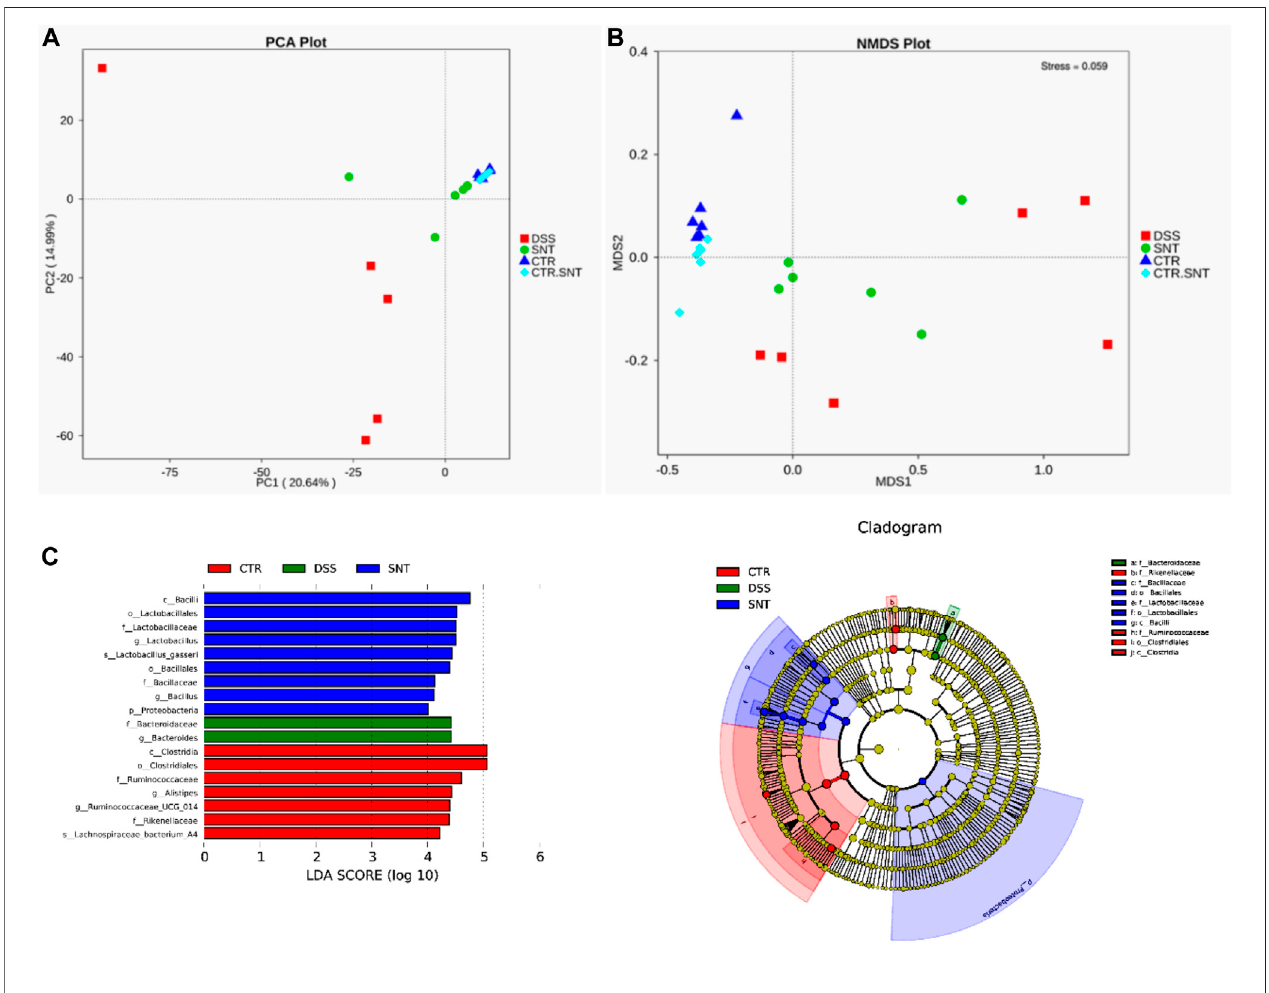
FIGURE7| Diversity analysisofgut microbiota inmice. (A) PCA analysis. (B) NMDS analysis. (C) LEfSe analysis. Bcteroidaese , Bacteroides in theCRC groupand Lactobacillales , Lactobacillaceae , Bacillales , Bacillaceae intheCRC +SNDgroup,whichmadeabigdifferencebetweengroupsbyusingLEfSeanalysiswerescreened.